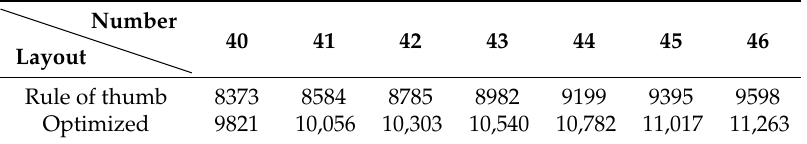
Figure 14. Rule of thumb layout of wind farm with fixed spacing of potential wind turbine locations on the cross-wind direction. Table 3. Comparison of total wind farm power output (in kW) with different number of wind turbines for rule of thumb layout and optimized wind farm layout.